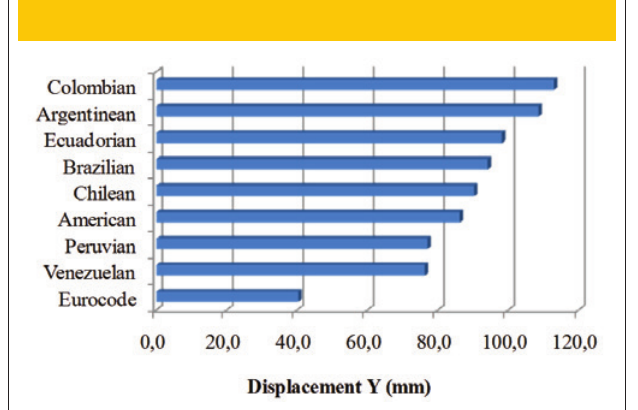
Figure 7 – Obtained displacements, direction Y